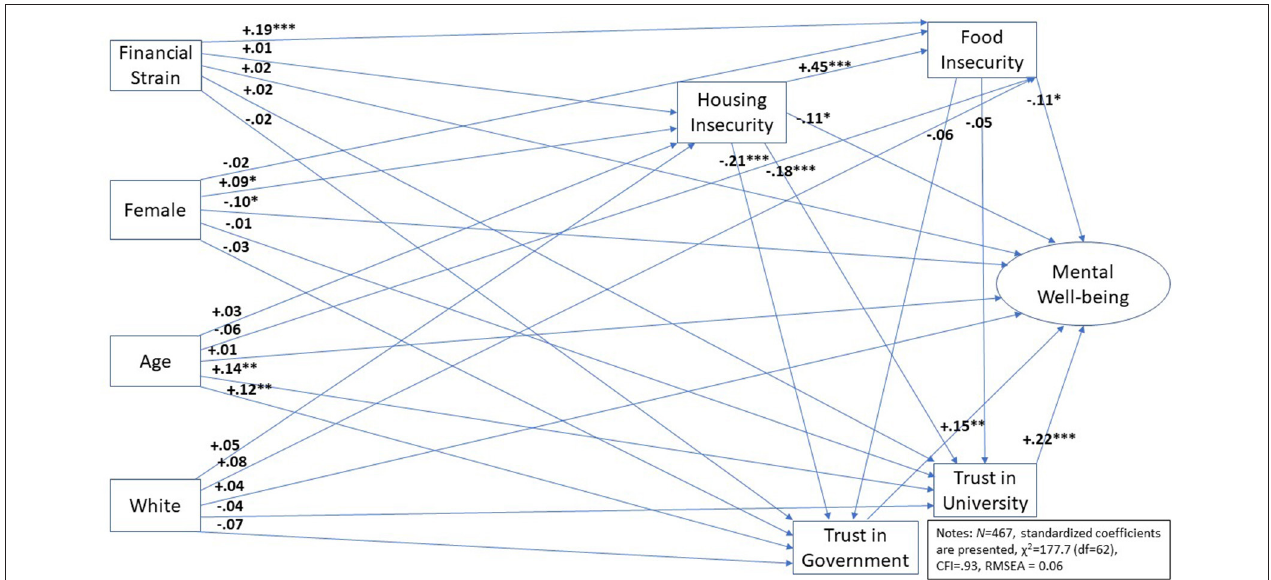
FIGURE 2 | Empirical model of university student mental well-being. * p < 0.05, ** p < 0.01, and *** p < 0.001.